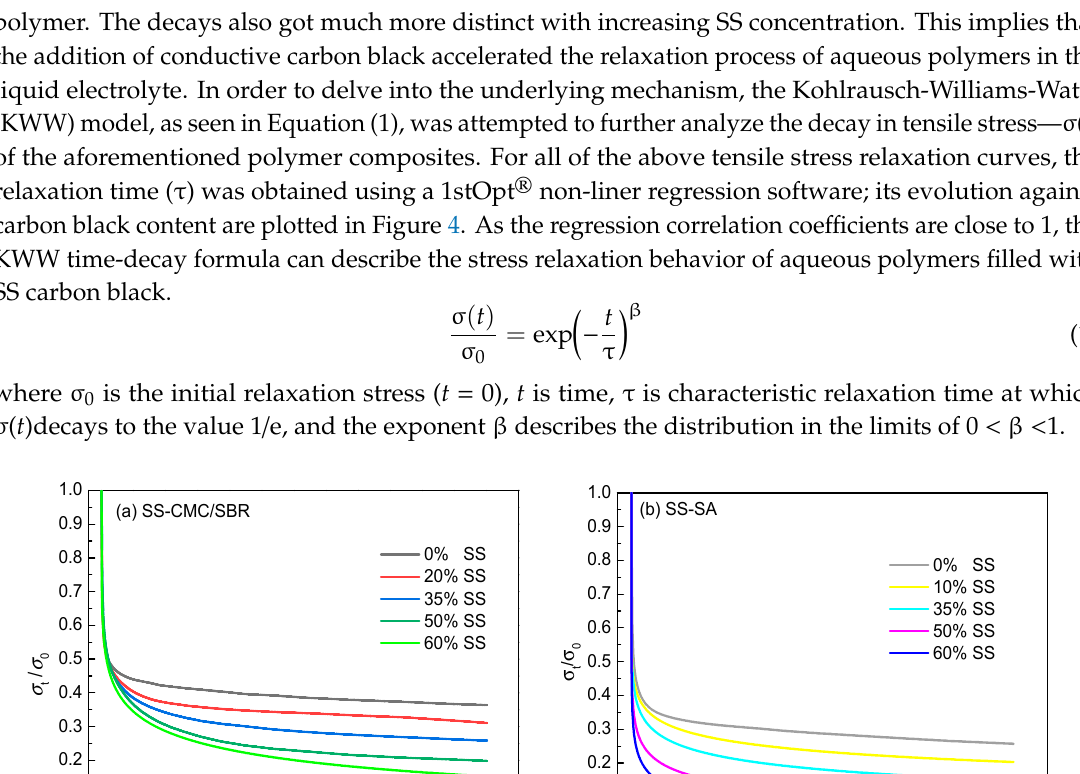
Figure 3. Normalized stress relaxation curves of cured ( a ) SS-SBR/CMC and ( b ) SS-SA films.